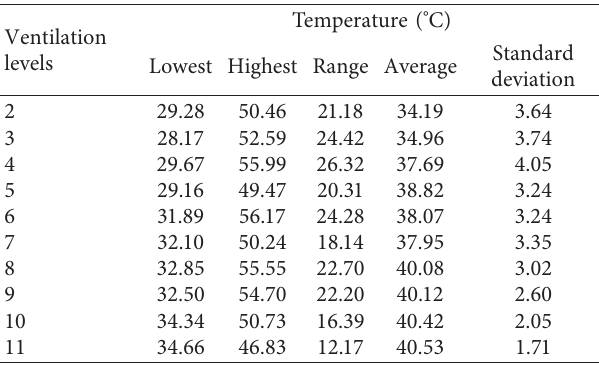
Table 4: Statistical characteristics of LST at different levels of ventilation